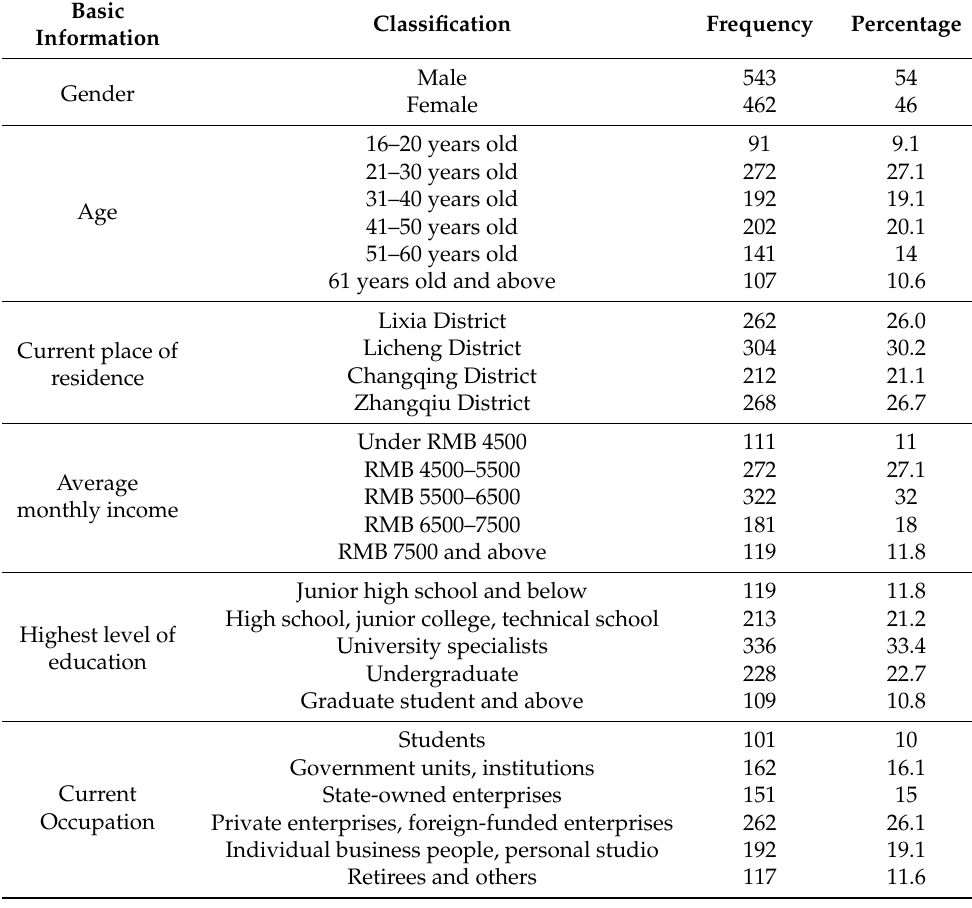
Table 5. Descriptive statistics of the